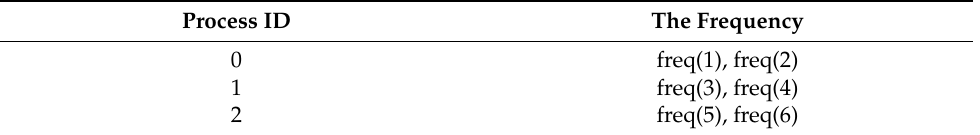
Table 1. The allocated